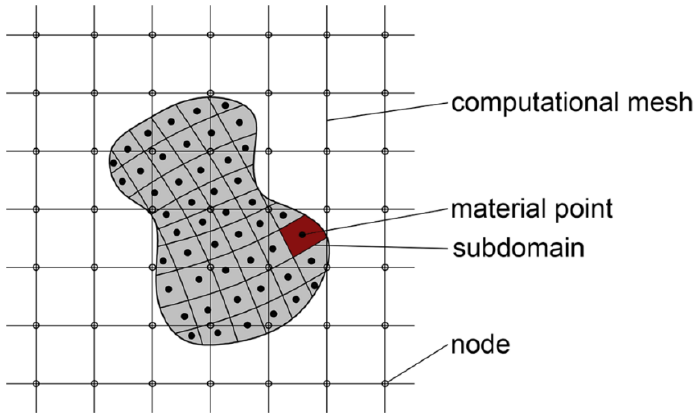
Figure 2. Scheme of the spatial discretization of the material point method (MPM).